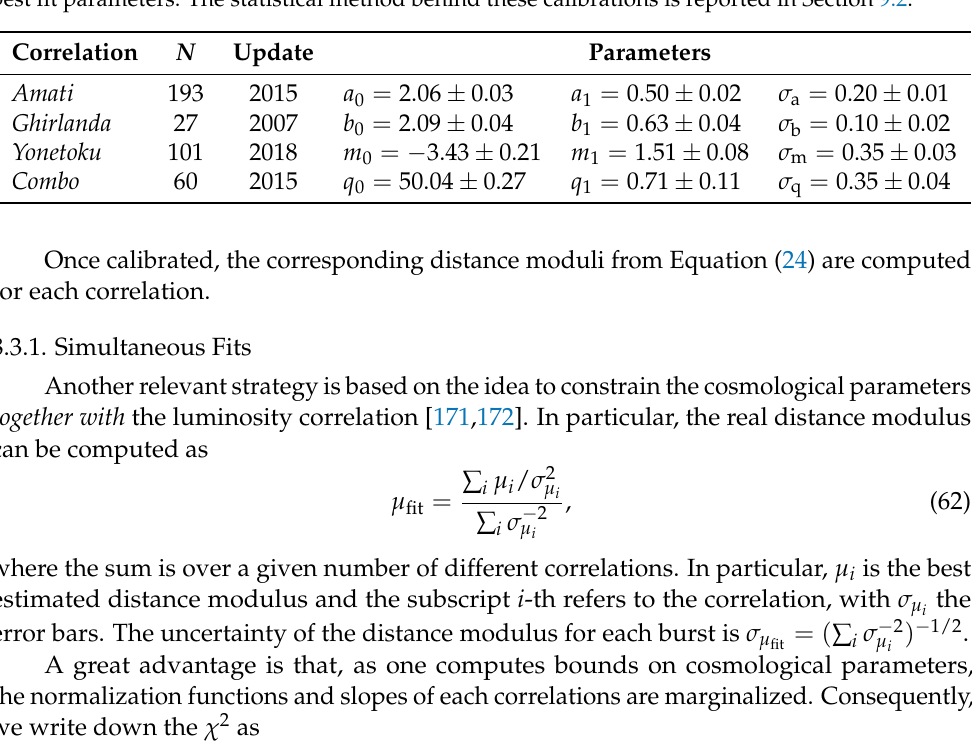
Table 1. For brevity, we report in this table only a few calibrated correlations. In particular, in the columns, we prompt four correlations, i.e., Amati, Ghirlanda, Yonetoku, and Combo, with the data set number points and the corresponding last update year. On the right, we display the calibrated best fit parameters. The statistical method behind these calibrations is reported in Section